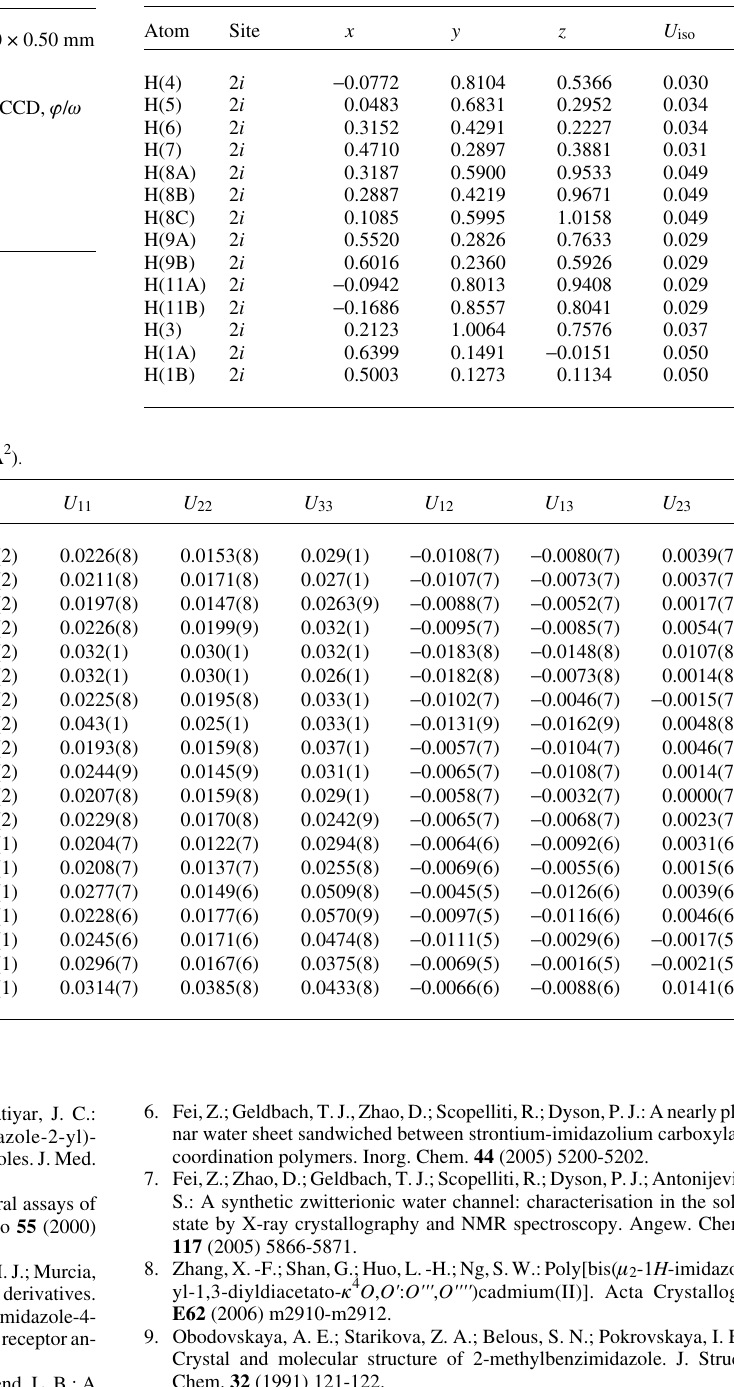
Table 1. Data collection and